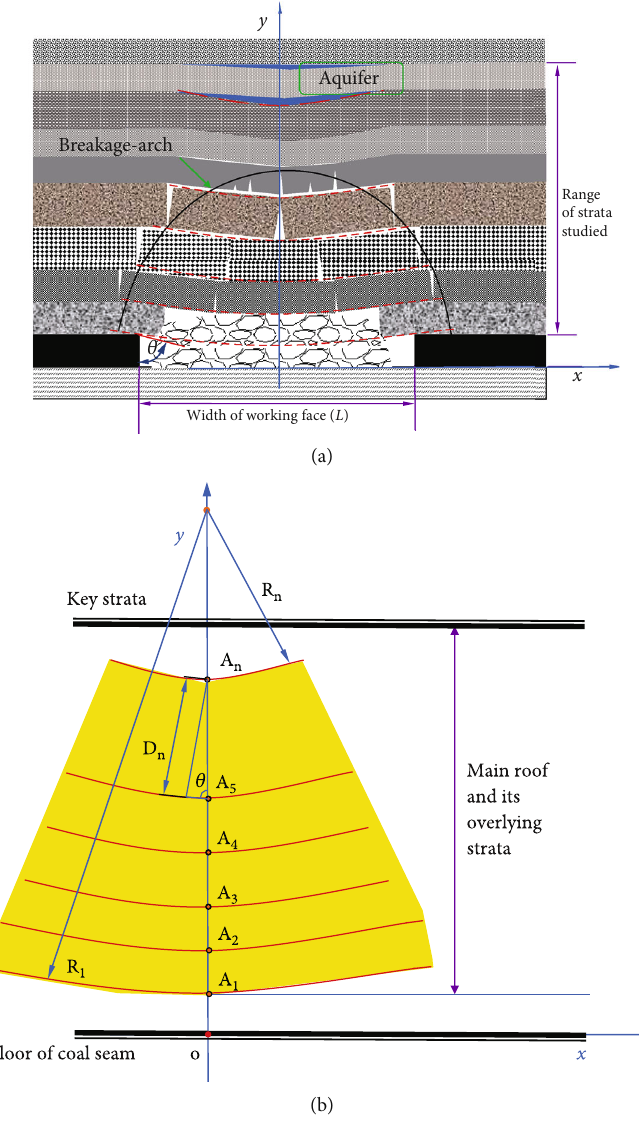
Figure 4: Schematic diagram of fi nal position state of upper strata fracture and